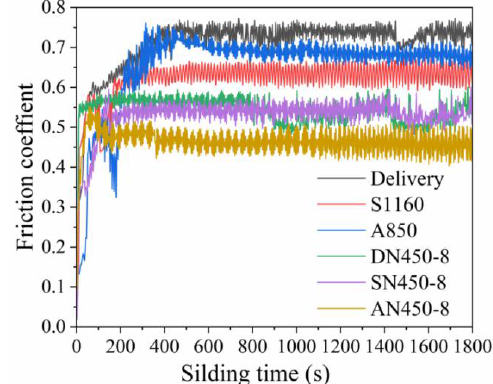
Figure 7. Friction coefficient curves of AISI 430 ferritic stainless steel with a different initial microstructure before and after low-temperature plasma nitriding.